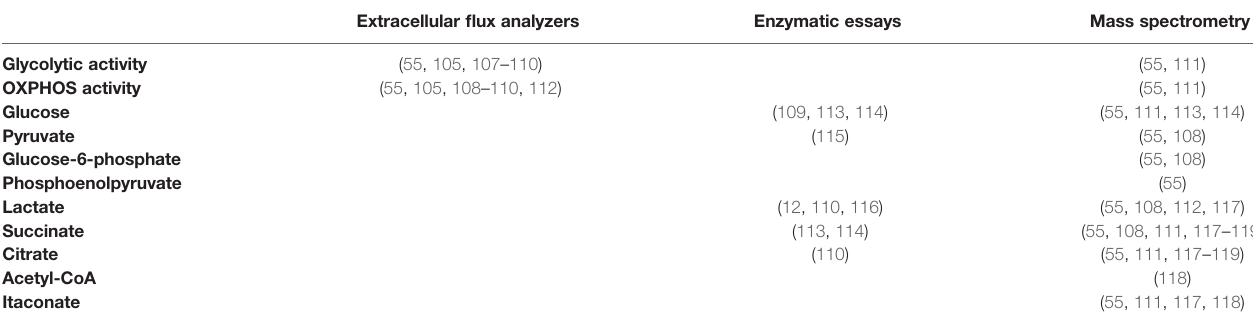
TABLE 1 | Metabolite analysis in macrophages metabolic